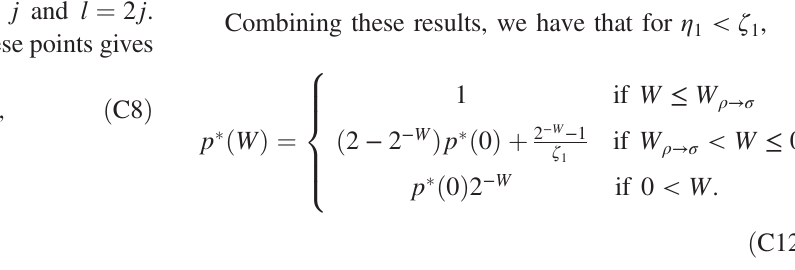
8. Here, we show how p (cid:3) ð W Þ varies as a function of W for qubits under noisy operations when W ρ → σ < 0 . Note the behavior at W ¼ 0 , indicating the function is not convex in W ≥ W ρ → σ